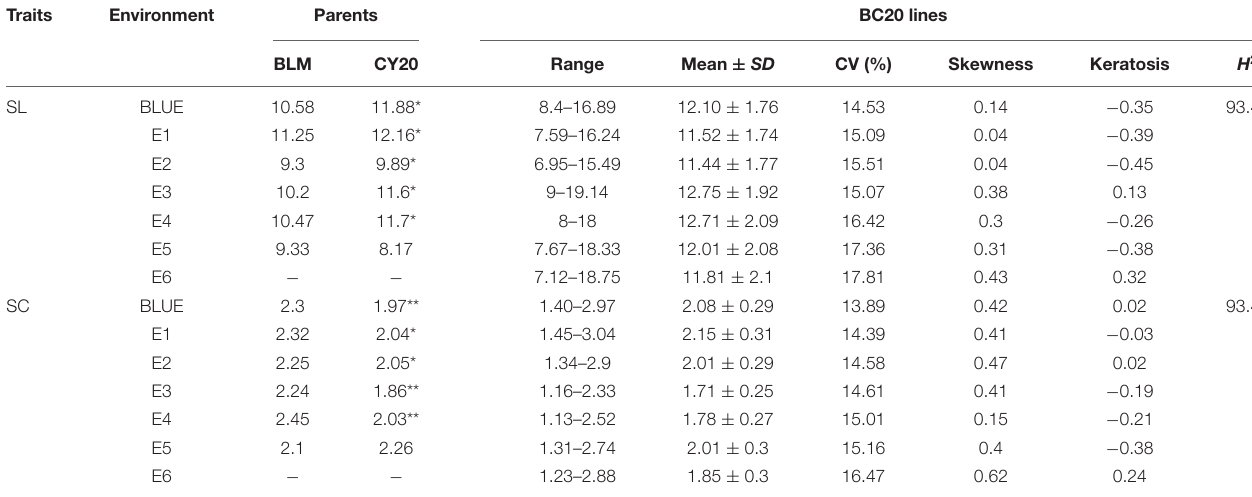
TABLE 1 | Phenotypic variation and heritability ( H 2 ) of spike compactness (SC) and spike length (SL) for parents and BC20 lines in different environments and the BLUE datasets. Traits Environment